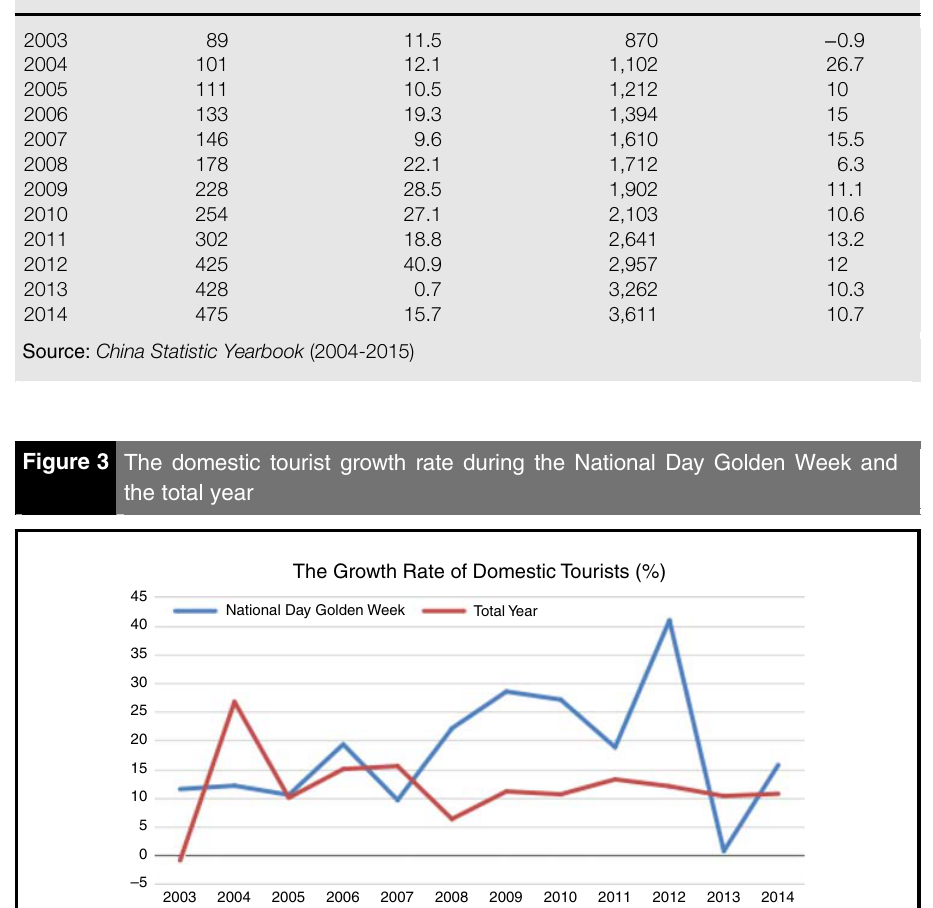
Table IV Statistics of domestic tourists during the “ National Day ” Golden Week and across the year “ National Day ” Golden Week Total year Year Million person-time